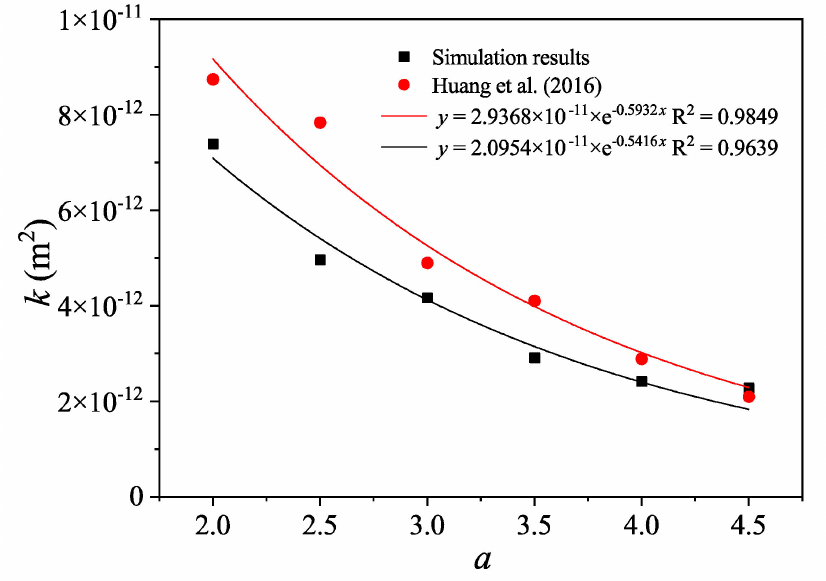
Figure 6. Comparisons of k between the simulation results calculated using the EPN models and results reported by Huang et al.